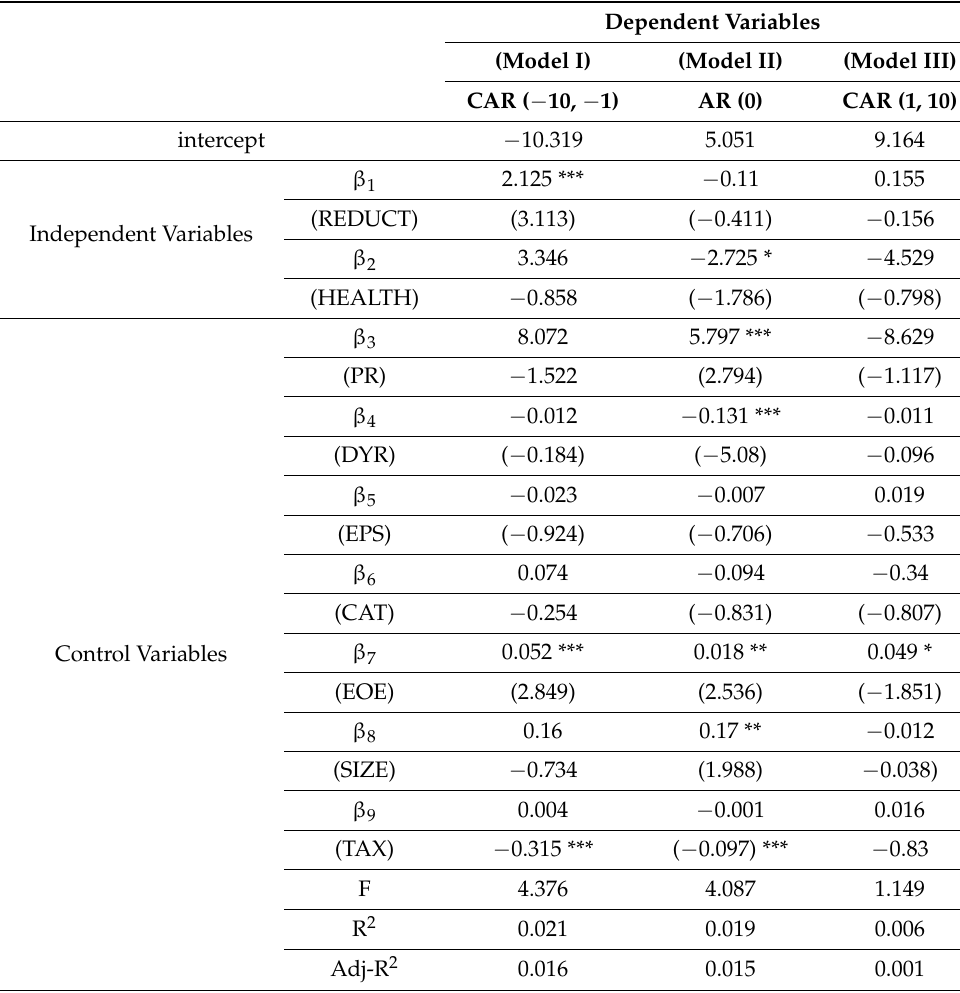
Table 2. The results of the